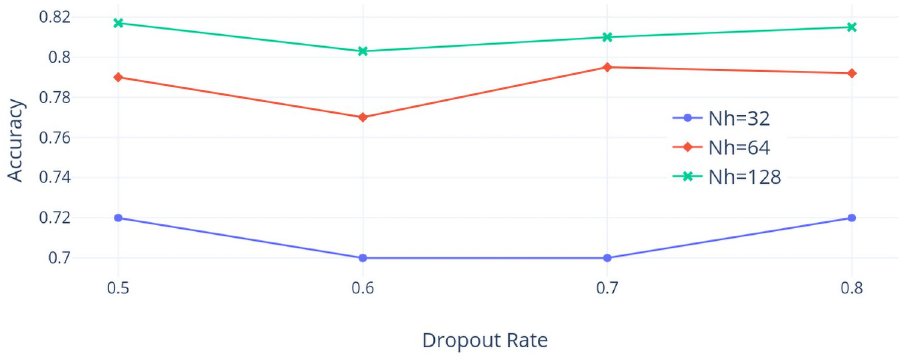
Fig 15. Accuracy with droupout rate varied (TX